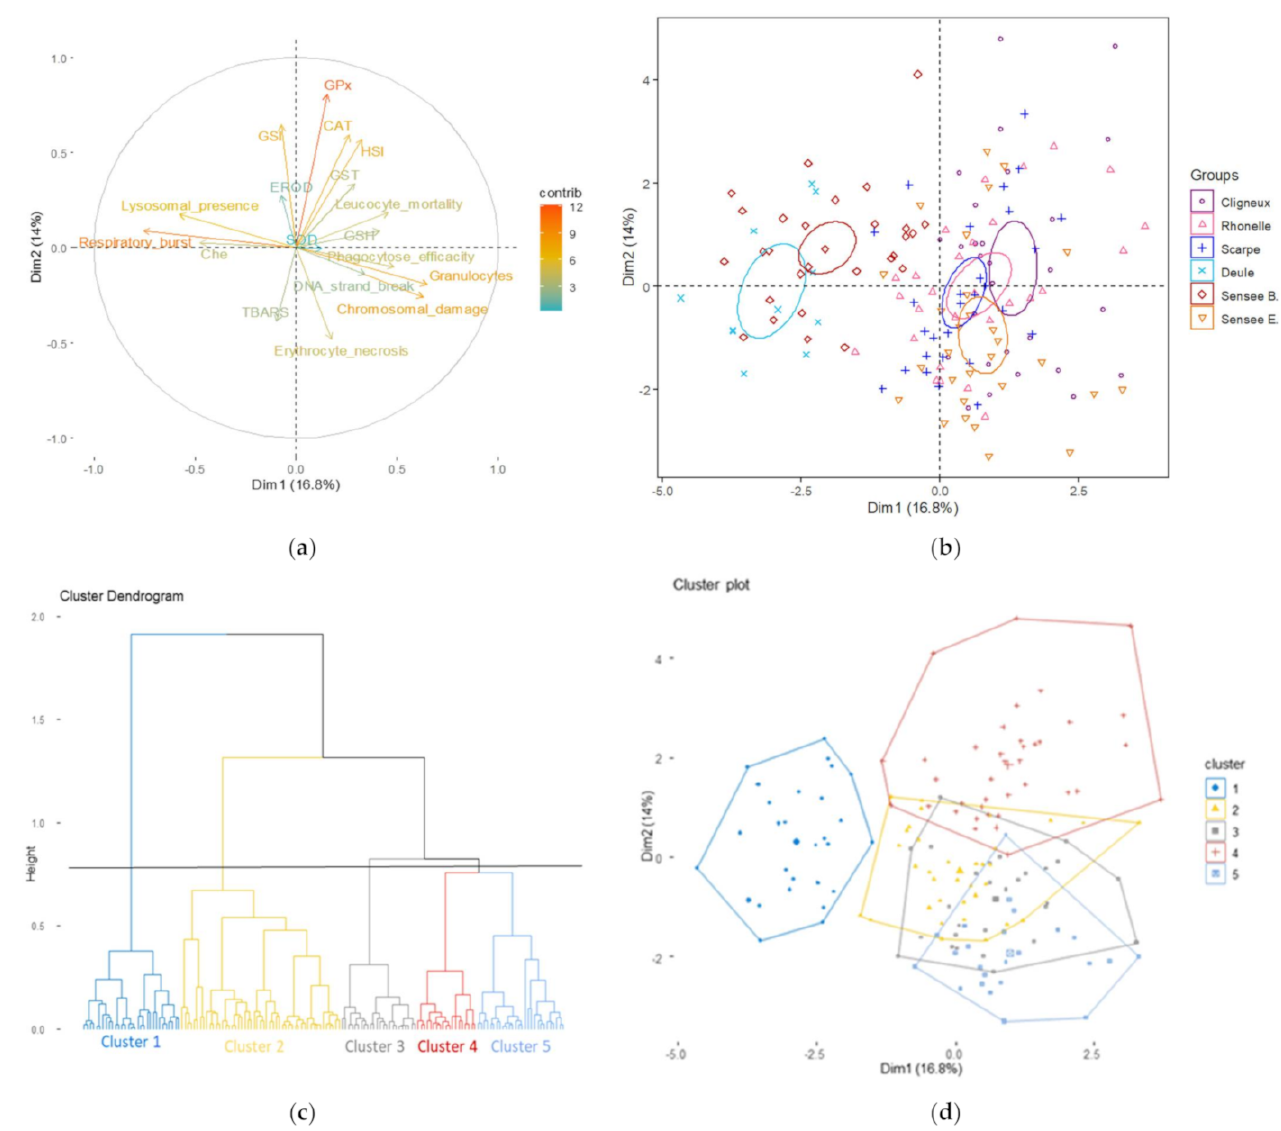
Figure 3. Results of the principal component analysis (PCA) with biometric, biochemical, immune and genotoxic biomarkers integrated in the battery (first and second component) followed by the hierarchical agglomerative clustering (HAC). PCA: ( a ) variables graph and ( b ) individual graph showing 95% confidence ellipses around the barycenter of different groups. Each dot represents one fish. ( c ) HAC represented by a dendrogram and ( d ) by an individual graphical